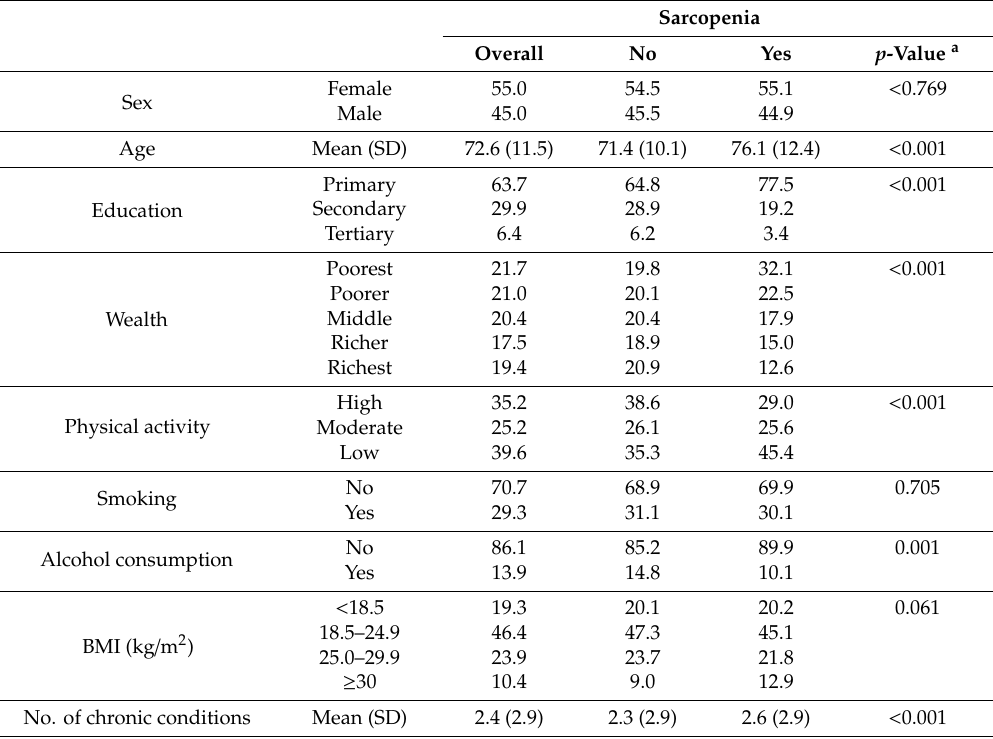
Table 1. Sample characteristics (overall and by